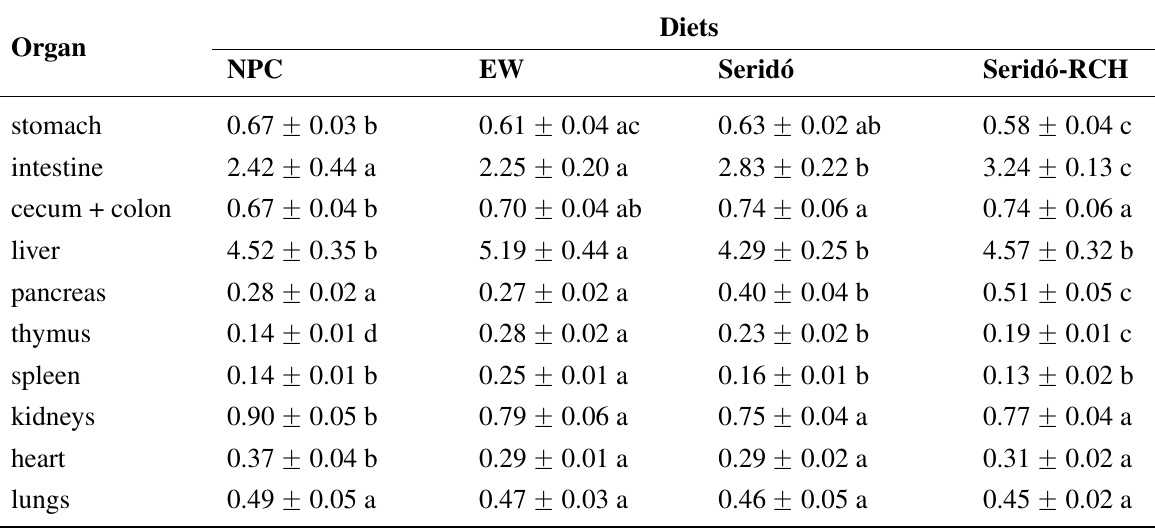
Table 5. Relative organ dry weights (g/100 g body dry matter) of rats fed with non-protein control (NPC), egg white (EW) and experimental diets